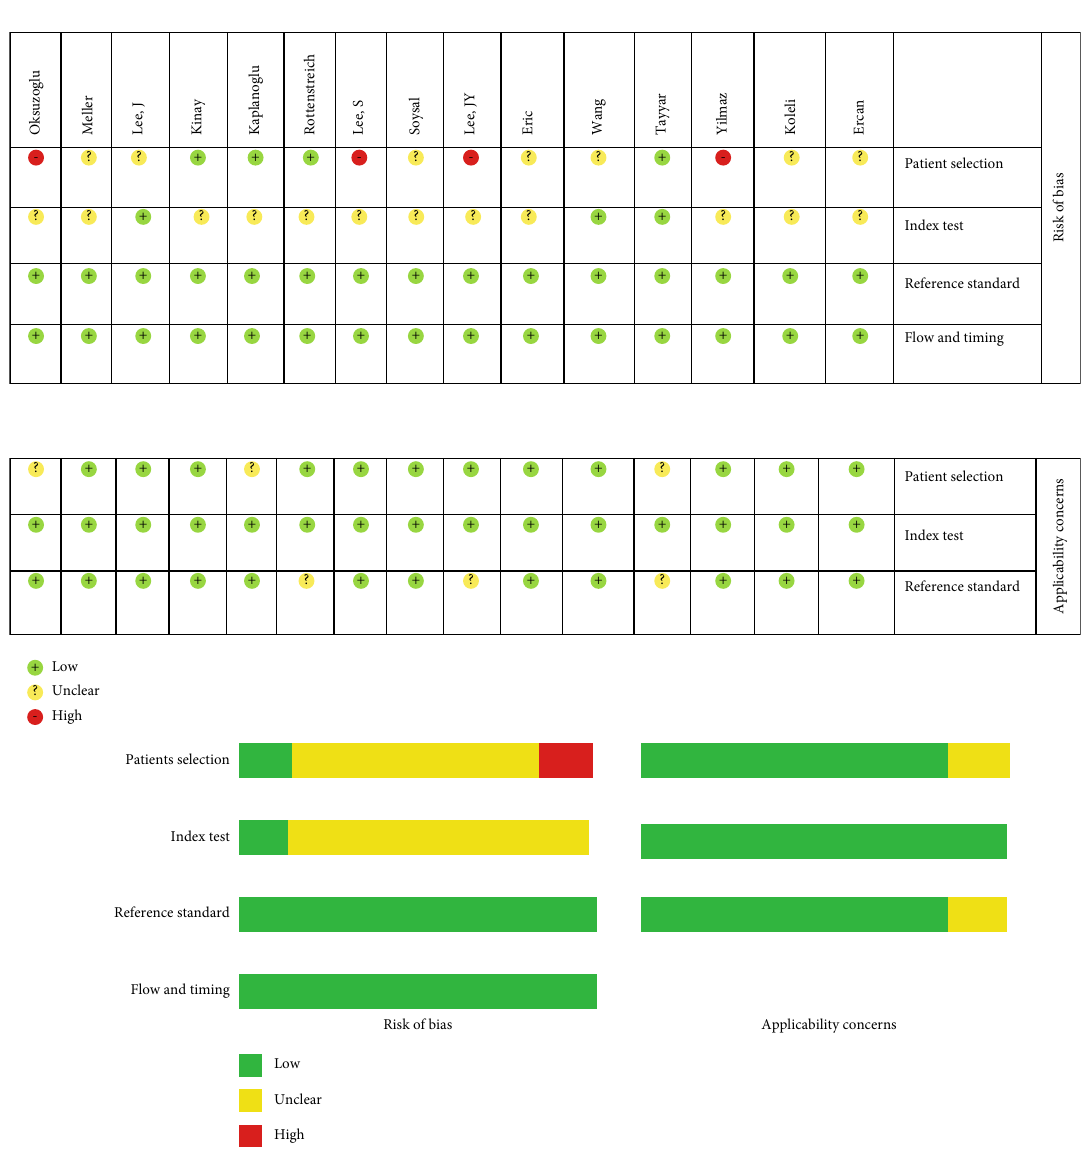
Figure 6: Quality assessment of included studies using QUADAS-2